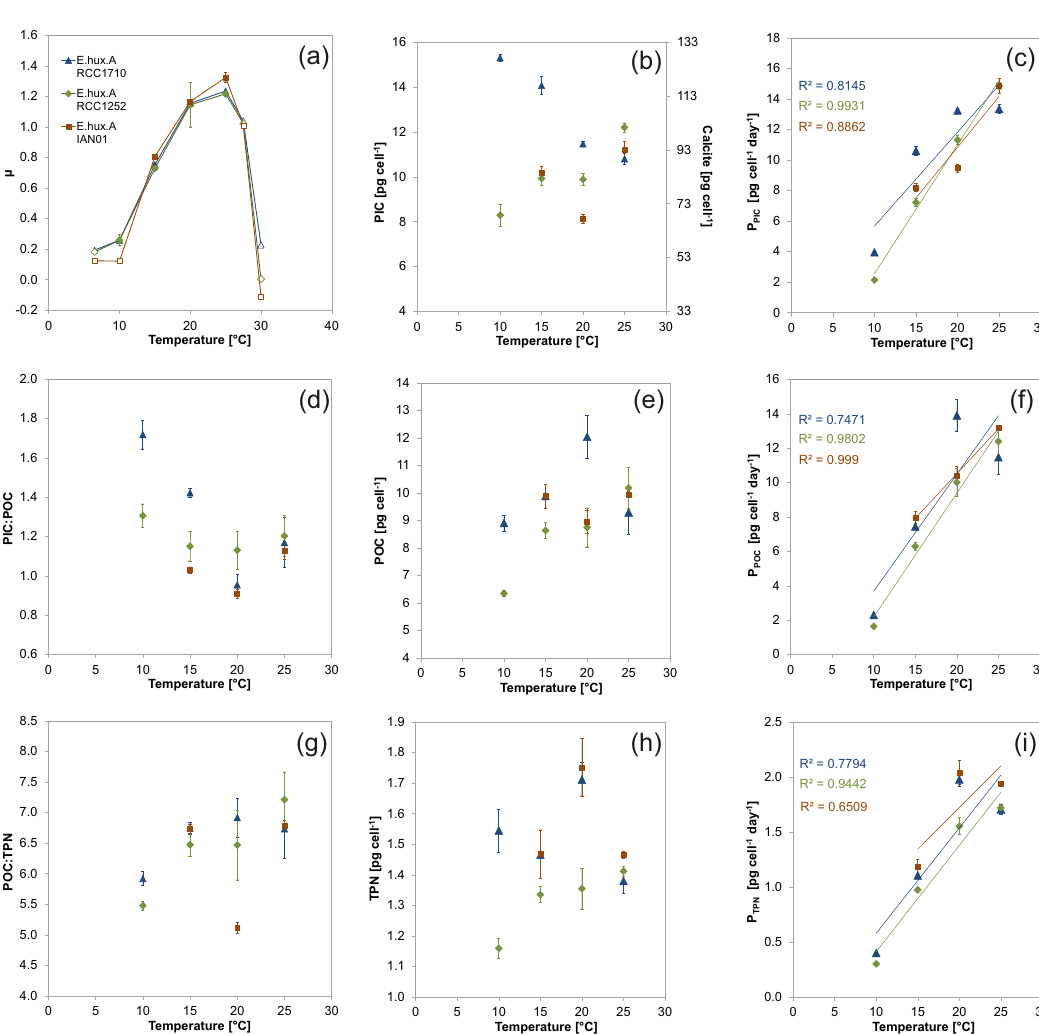
Figure 1. Results at different temperatures. Growth rate (a) (extra temperatures from pre-experiments are included and shown as empty symbols); cellular PIC and its concomitant calcite (b) , POC (e) and TPN (h) content; PIC (c) , POC (e) and TPN (i) production (linear trend lines and r squared values are shown); and PIC:POC ratio (d) and POC:TPN ratio (g) . Standard deviations of the triplicate